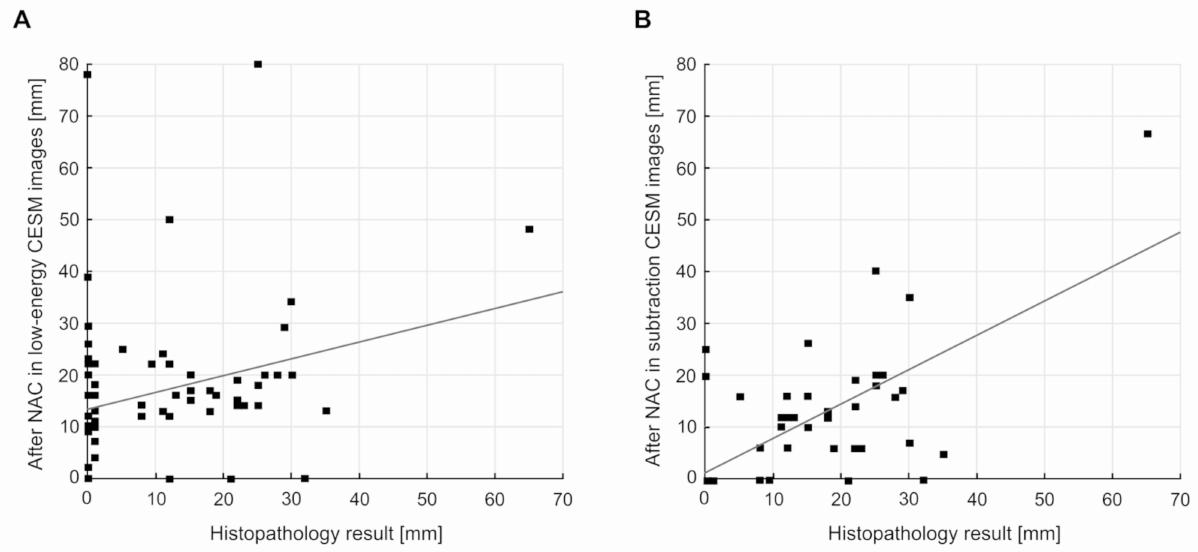
Figure 1. Correlations between: ( A ) the maximum tumor size before NAC in low-energy and subtraction CESM images: R = 0.89, p < 0.01; ( B ) the maximum tumor size after NAC in low-energy and subtraction CESM images: R = 0.57, p < 0.01.